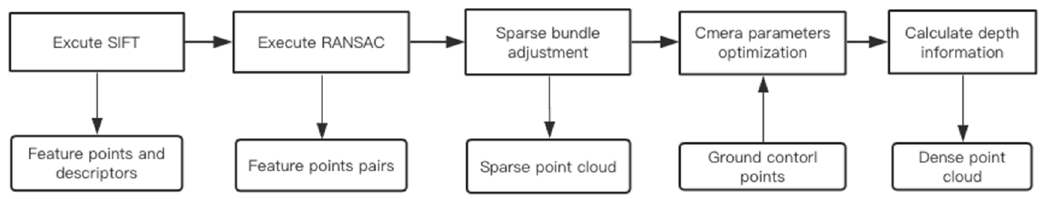
Figure 2. Structure from motion (SfM) workflow.